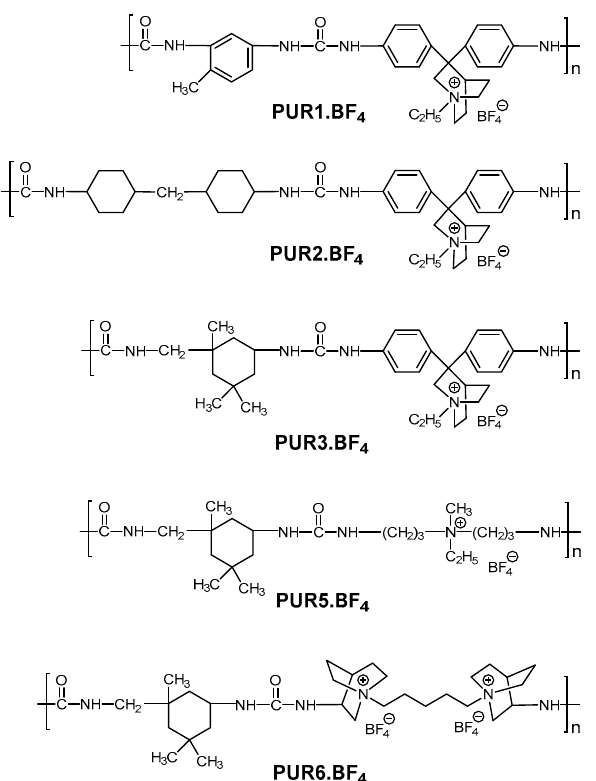
Scheme 3. Structures of ionic polyureas (PURs) synthesized and studied in the present